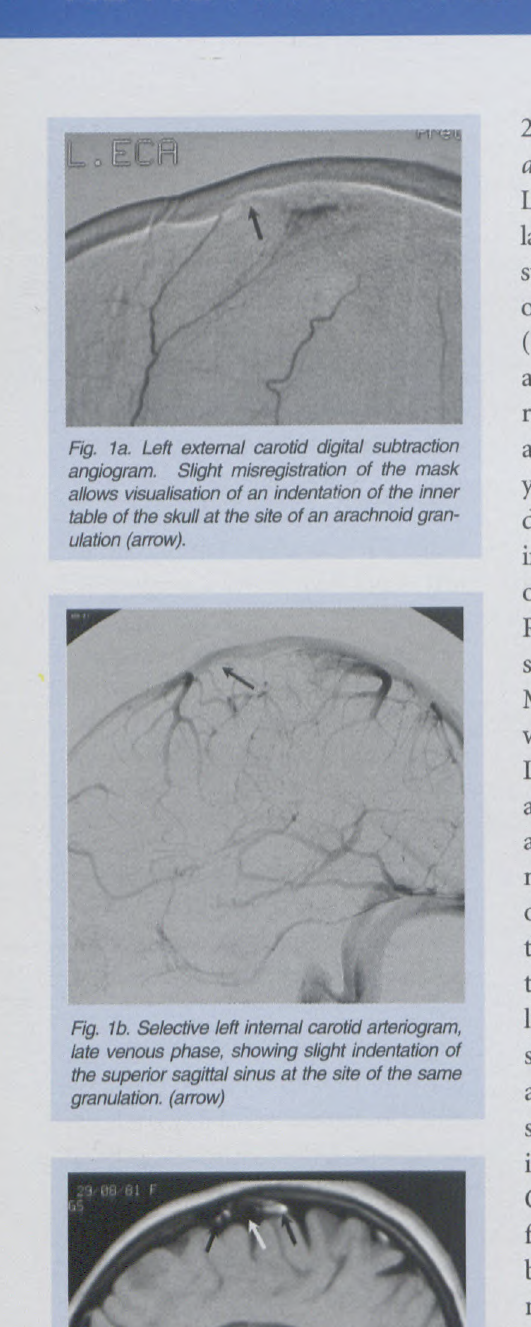
Fig. 2a. Coronal gadolinium-enhanced Tt MR scan showing the passage of the 'bridging'seg- ment of the cortical veins traversing the arachnoid spaces exaggerated by the presence of bilateral chronic subdural fluid collections (arrow).